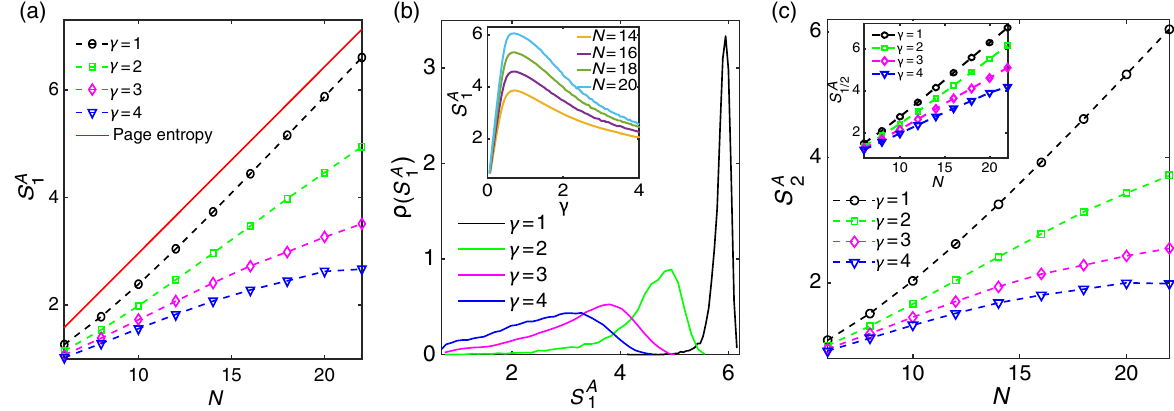
FIG. 4. Entanglement scaling and distributions of neural-network states with random weight parameters. (a) The averaged von Neumann entropy S A 1 . For small γ ( γ ¼ M=N denoting the ratio between the number of hidden and visible neurons), S A 1 scales linearly with the system size, indicating a volume-law entanglement. However, S A 1 tends to saturate when γ becomes large ( γ ¼ 4 ). Moreover, for all γ values studied, S A 1 deviates significantly from the Page value for the entanglement entropy averaged over random pure states. (b) The entanglement distribution of S A 1 for different γ . The peak shifts to the left as γ increases, which is consistent with the observation that the averaged S A 1 decreases as we increase γ . Here, the system size is chosen to be L ¼ 20 , and we have used 10 4 random samples. The inset shows S A 1 as a function of γ for different system sizes. Note that S A 1 reaches its maximal value at γ (cid:4) ≈ 0 . 7 . However, even this maximal value of S A 1 is still noticeably smaller than the Page value for random states. (c) The scaling of the Rényi entropy with the system size. The second-order Rényi entropy S A 2 behaves similarly to the von Neumann entropy S A 1 . The inset shows the results for S A 1 = 2 . For simplicity, we have chosen the on-site potentials a k ( k ∈ ½ 1 ; N (cid:2) ) and b k 0 ( k 0 ∈ ½ 1 ; M (cid:2)Þ to be zero. The connection weight parameters W W ∈ ½ − 3 =N; 3 =N (cid:2) and Im ð W ∈ ½ − π ; π (cid:2) kk 0 are complex numbers randomly drawn from uniform distributions with Re ð kk 0 Þ kk 0 Þ